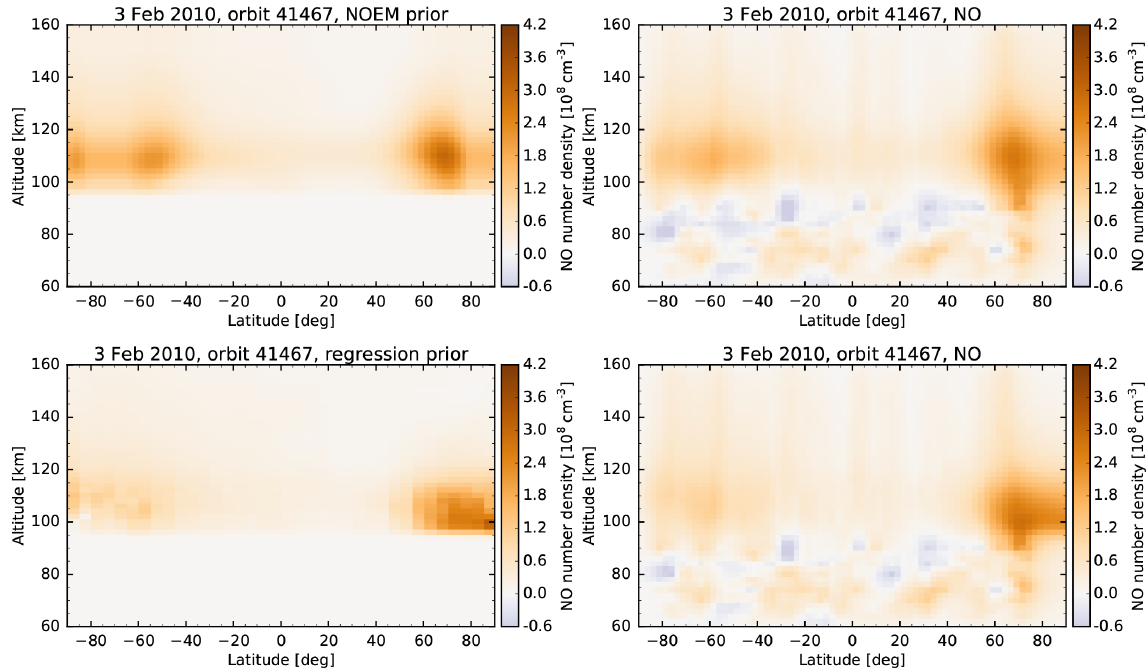
Figure 4. NO number density a priori input from the NOEM model (upper left) and the regression model (lower left). Retrieved NO number densities from the limited SCIAMACHY MLT limb scans using the NOEM model (upper right) and the regression model (lower right) a priori input (sample orbit no. 41467, 3 February